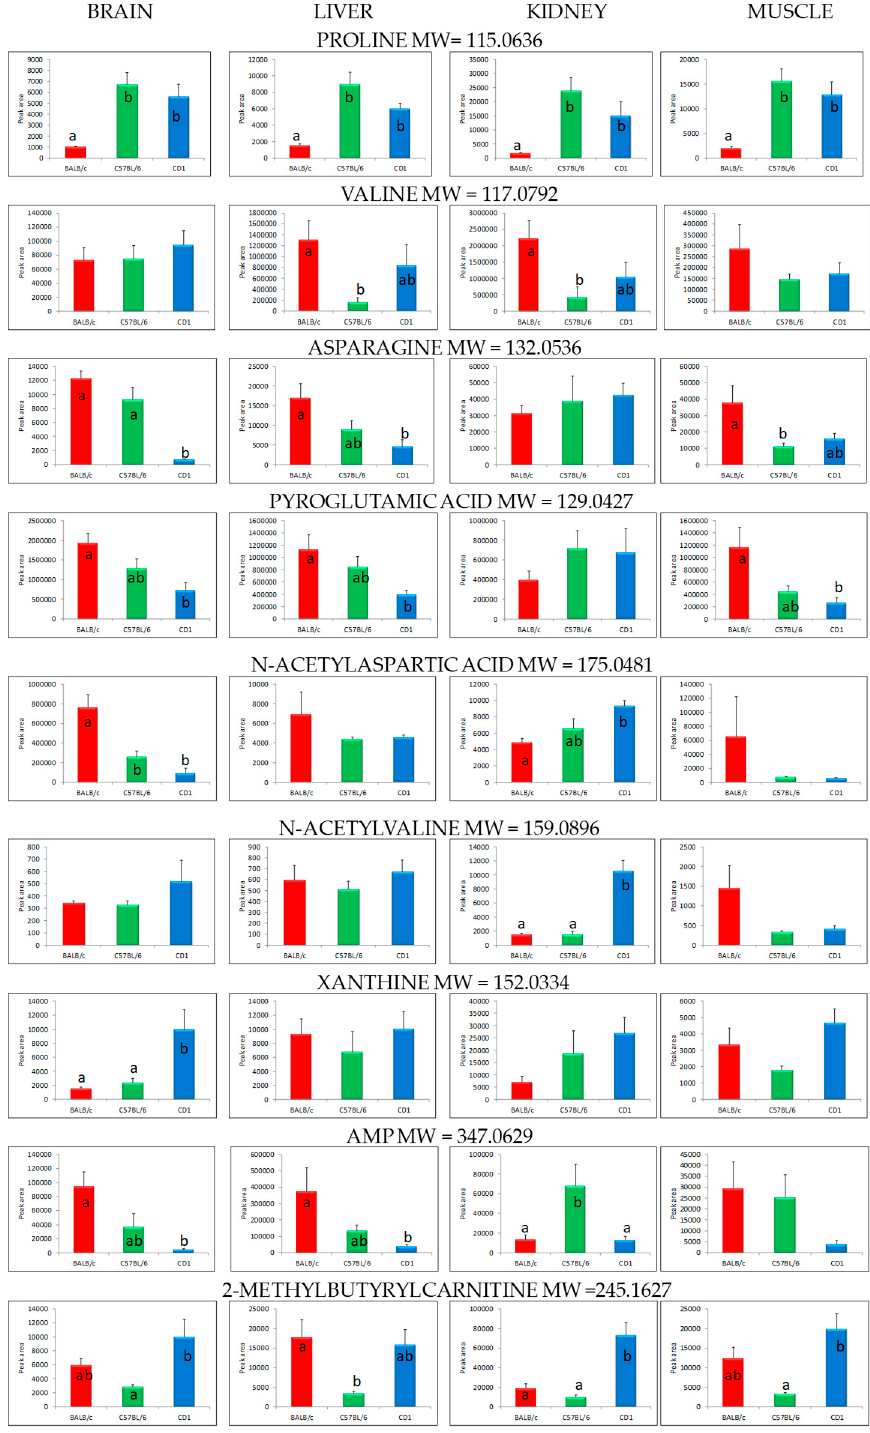
Figure 3. Levels of selected metabolites present in brain, kidney, liver and muscle tissues of BALB/c, C57BL/6 and CD1 mice. Data is presented as mean ± standard error of the mean (bar: x ̅ ; whisker- standard error of x ̅ ); a, b: bars with different letters differ significantly at p < 0.05 (post-hoc Tukey HSD test); MW: molecular weight.